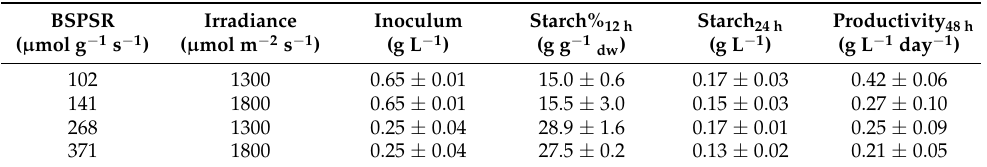
Table 2. Experimental parameters and results from experiment 2. The experimental parameters were biomass-specific photon supply rate (BSPSR), light intensity and inoculum density, vs the resulting starch concentration in the biomass 12 h after N starvation, starch concentration in the culture 24 h after N starvation, and biomass productivities after 48 h. Average values ±